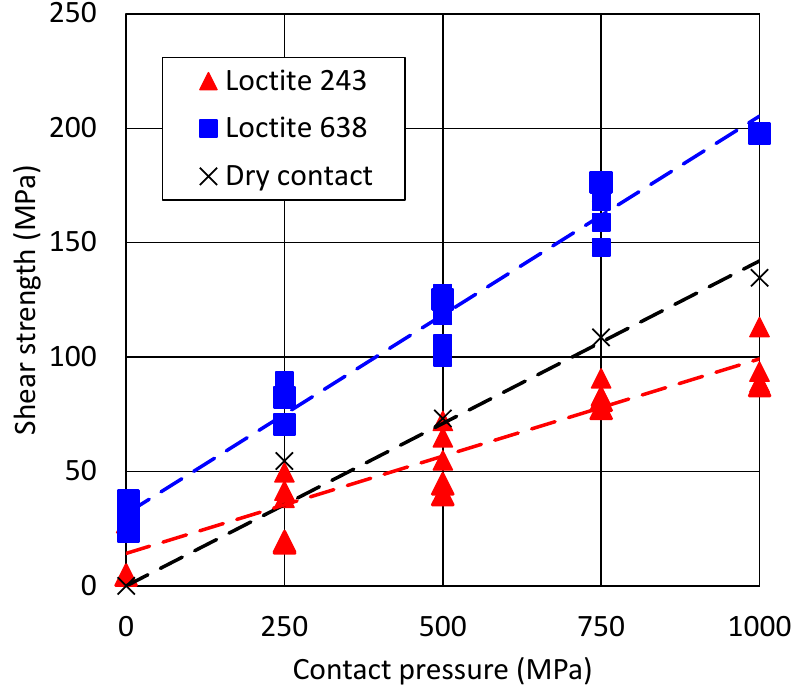
refer to Loctite 243. The solid blue squares refer to Loctite 638. The black crosses refer to a dry interface. The dashed lines are the linear regression of the corresponding points.